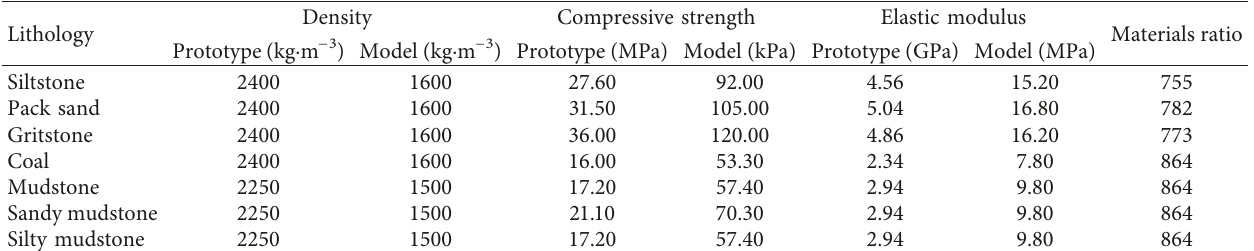
Table 2: Lithology and physical-mechanical parameters of roof-floor strata [14].